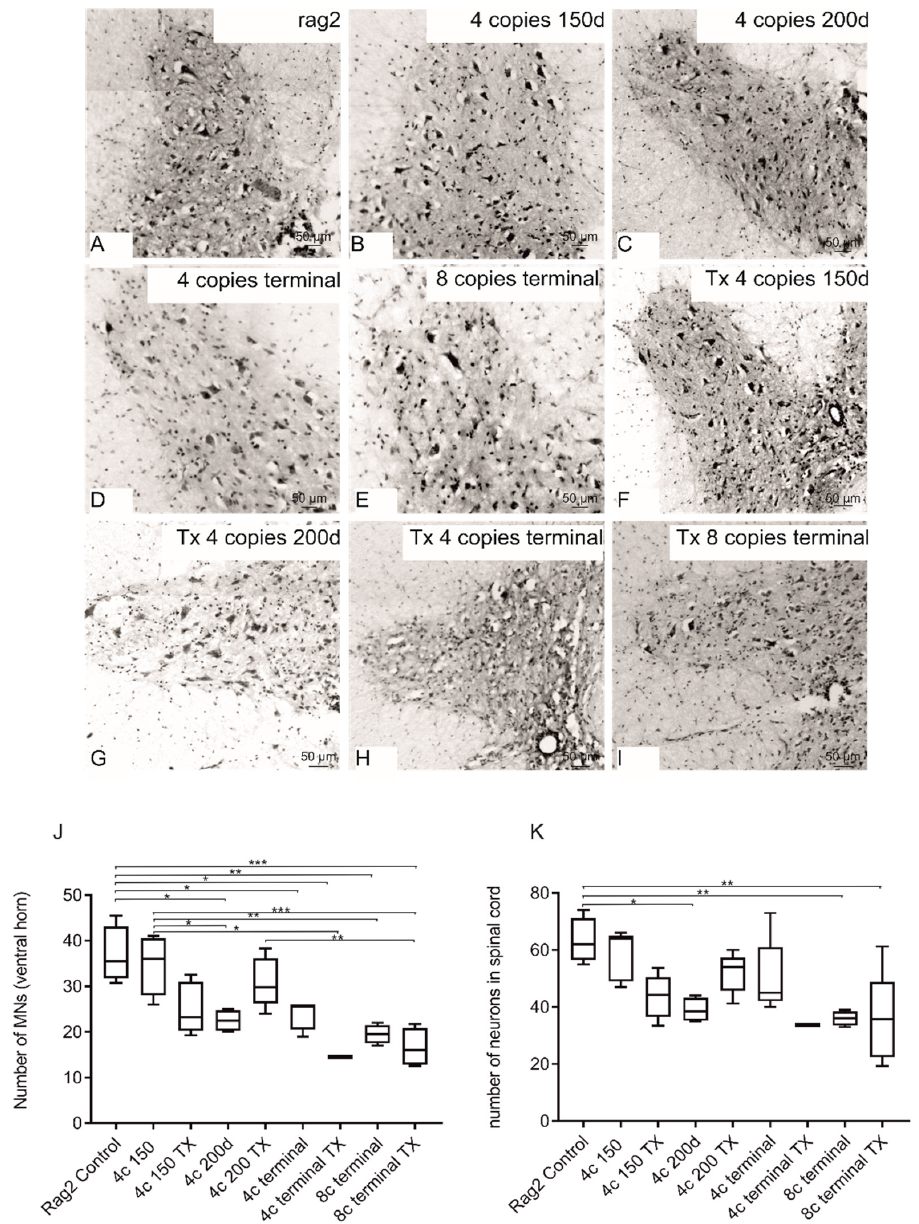
Figure 5. Morphological analysis of MNs in spinal cords of transplanted ( F – I ) and nontransplanted animals ( B – E ) compared with rag2 control ( A ) show reduced number and size of MNs in SOD1 comparison with rag2 animals. Quantitative analysis ( J , K ) did not reveal diminished MN counts in transplanted animals ( J ) as well as in the total number of neurons in the spinal cord (K). The following symbols of the level of statistical significance were adopted: p < 0.05 *; p < 0.01 **; p < 0.001 ***. Values are presented as mean ± SD. Sample size within the Rag2 control group: n = 4; SOD1/rag2 nontransplanted 4-copy group at 150 days: n = 5; SOD1/rag2 transplanted 4-copy group at 150 days: n = 4; SOD1/rag2 nontransplanted 4-copy group at 200 days: n = 4; SOD1/rag2 transplanted 4-copy group at 200 days: n = 6; SOD1/rag2 nontransplanted 4-copy terminal group: n = 5; SOD1/rag2 transplanted 4-copy terminal group: n = 1; SOD1/rag2 nontransplanted 8-copy terminal group: n = 4; SOD1/rag2 transplanted 8-copy terminal group: n = 4.